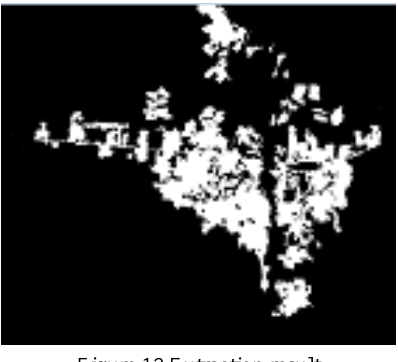
Figure 12 Extraction